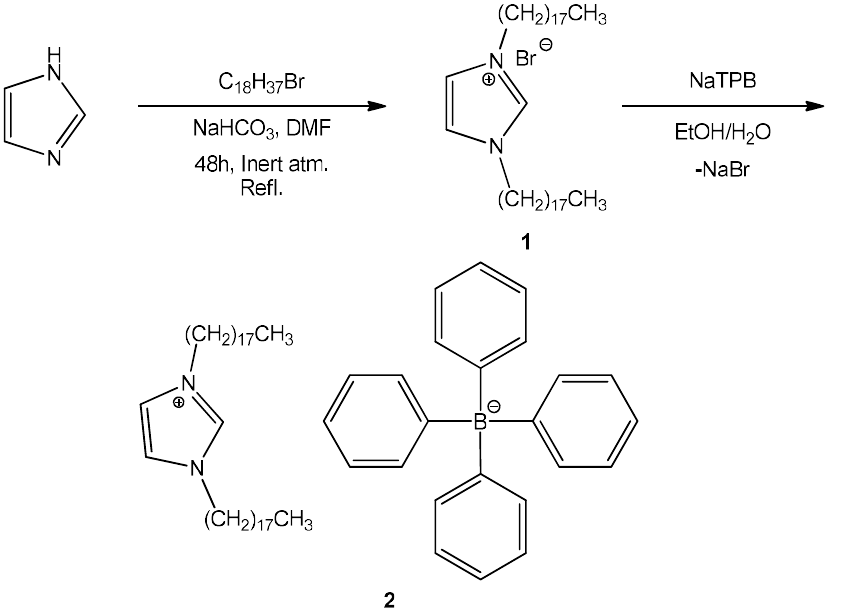
Figure 1. Synthesis of DODI–TPB ion-pair sensing complex ( 2 ) using quaternary alkyl ammonium salt 1,3-dioctadecyl-1 H -imidazol-3-ium bromide ( 1 ).